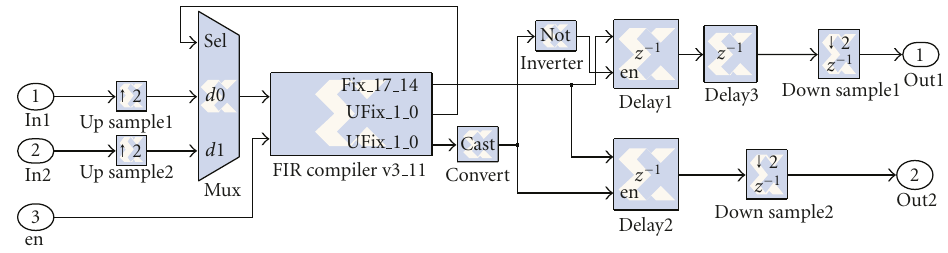
Figure 4: Optimized blocks for applying the Doppler Spectrum.